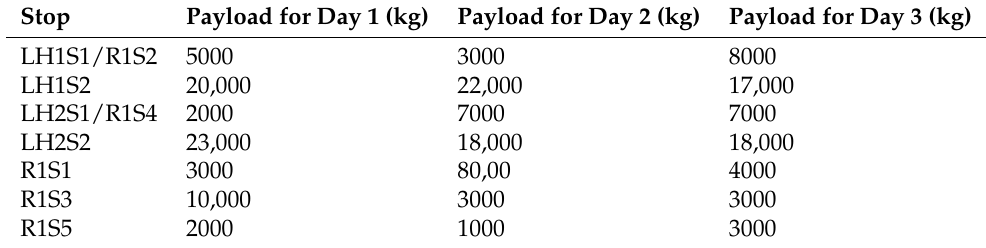
Table 3. Payload weight for different stops for three days of fleet